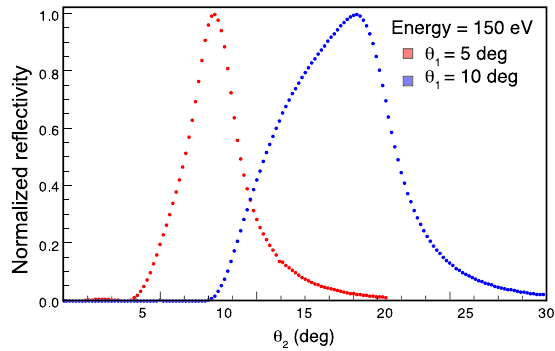
FIG. 22. Data sets Th7-Th8: scan of θ 2 for θ 1 ¼ 5 ° and θ ¼ 10 °, energy 150 eV, aluminum sample #1. 1